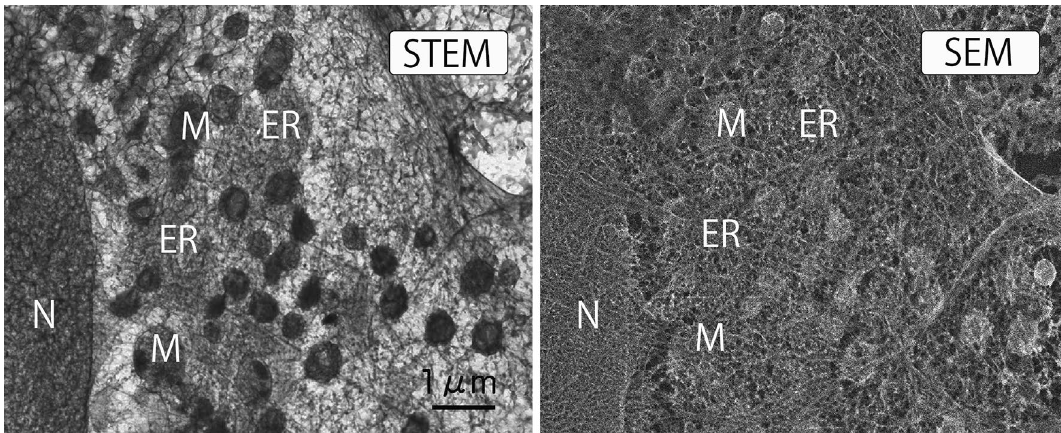
Figure 6. Simultaneous cryo-STEM image and SEM image showing a partially unroofed cell. Many organelles remain despite complete ablation of the apical cell membrane. Deep sublimation reduced the ice layer for electrons to pass through the cell. At the same time, the undulation in the cytoplasm could be observed in the SEM image. N nucleus, M mitochondria, ER endoplasmic reticulum.